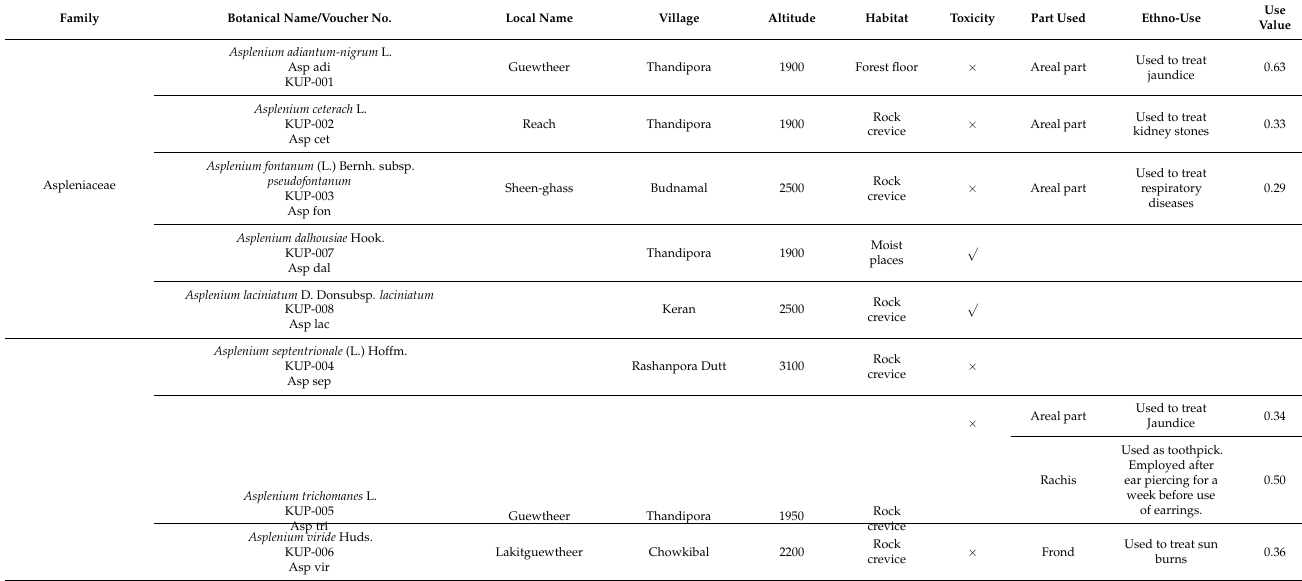
Figure 3. Representation of the species collected during the field study. (P.C. Aadil Abdullah Khoja ). Table 2. Inventory of the documented species from the administrative Kupwara district of Jammu and